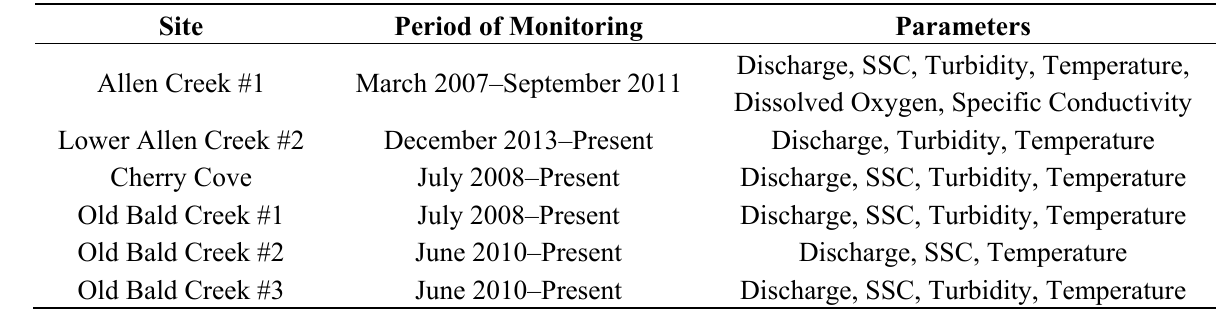
Figure 1. Map showing location of the upper Allen Creek basin (Waynesville Municipal Watershed) in North Carolina, and the location of the monitoring sites within the watershed: (1) Allen Creek #1; (2) Cherry Cove; (3) Old Bald Creek #1; (4) Old Bald Creek #2; (5) Old Bald Creek #3; (6) Lower Allen Creek #2. Table 1. Summary of instrumented sampling sites within the Allen Creek